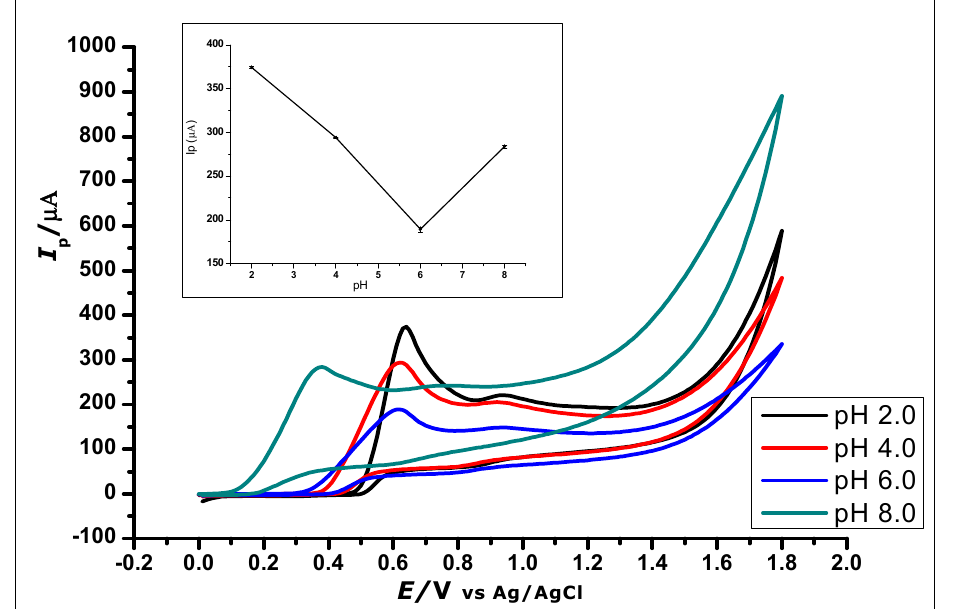
Figure 8. Cyclic Voltammograms showing the e ff ect of pH on the electrochemical behaviour of 1 × 10 − 2 mol L − 1 Gallic Acid at pH range of 2.0–8.0 (Inset). The plot of the Peak Current (I p ) against di ff erent pH values, showing the e ff ect of pH on the electrochemical behaviour of 1 × 10 − 2 mol L − 1 gallic acid using ZrO 2 nanoparticles modified CPE at a scan rate of 100 mVs − 1 .